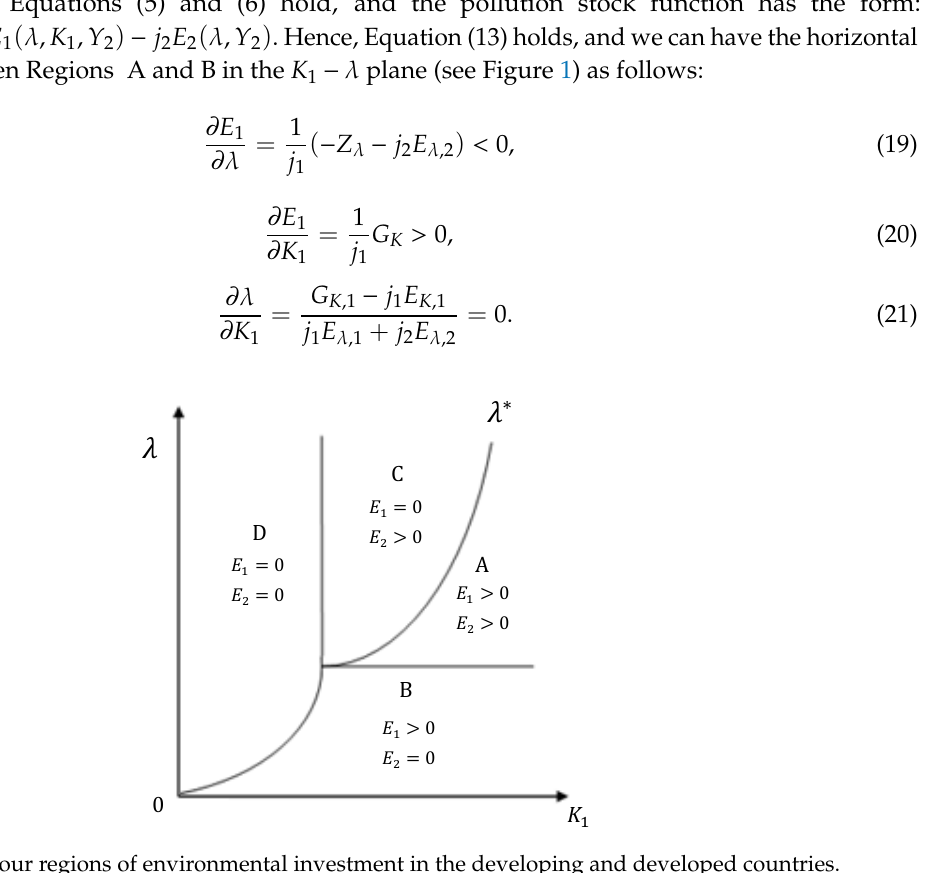
Figure 1. Four regions of environmental investment in the developing and developed countries.